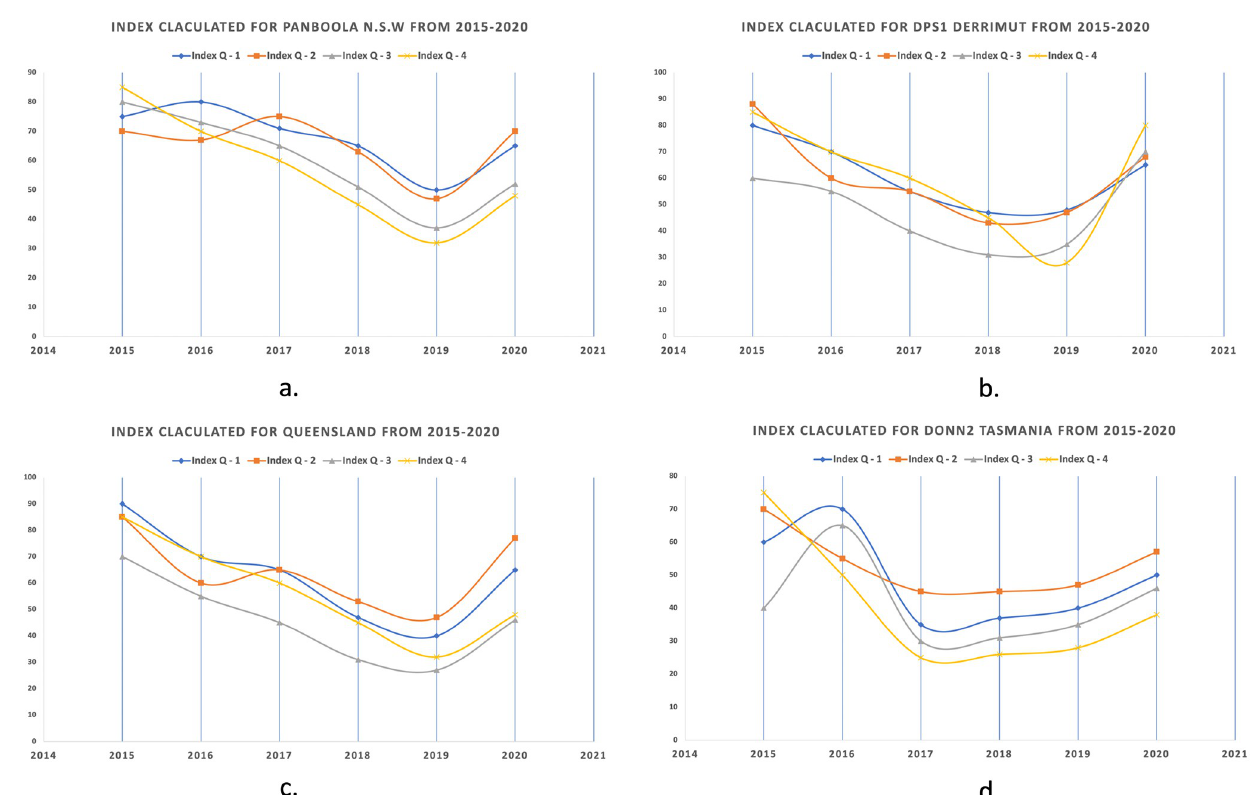
Fig 13. Trends of vegetation with respect to environmental factors from 2015-2020 quarterly for a.) Panboola (NSW), b.) Derrimut (VIC), c.) Queensland and d.) Donn2 (Tasmania).